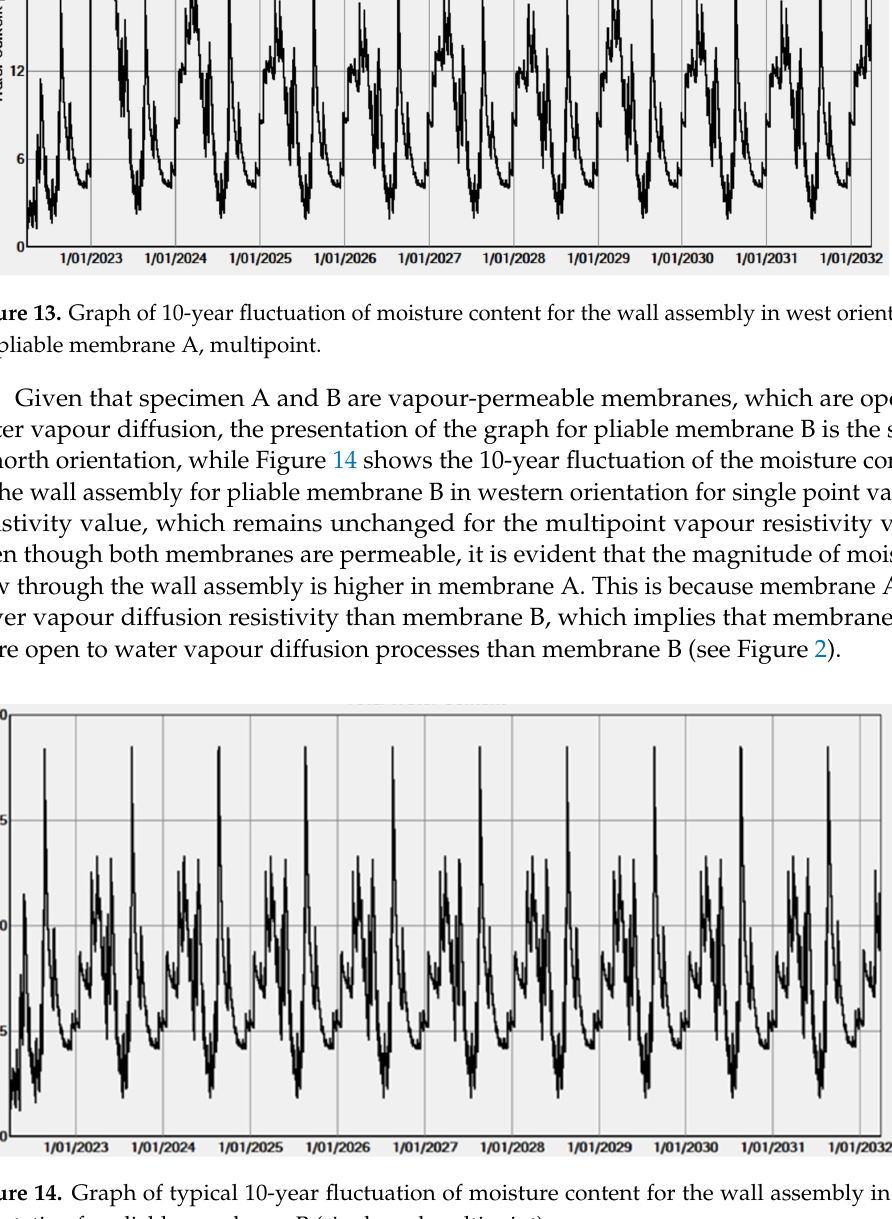
Figure 12. Graph of 10-year fluctuation of moisture content for the wall assembly in west orientation for pliable membrane A with single point.